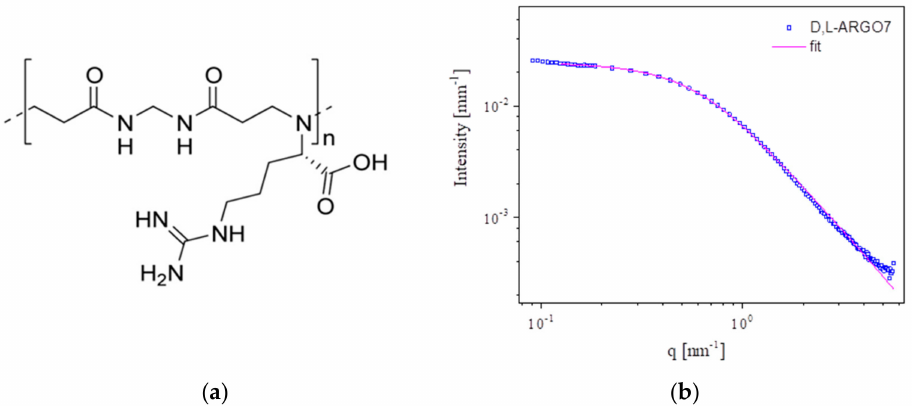
Figure 1. ( a ) Chemical structure of d , l -ARGO7. ( b ) SAXS intensity profile of d , l -ARGO7 at pH = 6.8 and 135 mM NaCl. Blue squares refer to the experimental data, while in pink it is reported the best fit by a Gaussian coil polymer chain model of radius of gyration 2.5 nm.